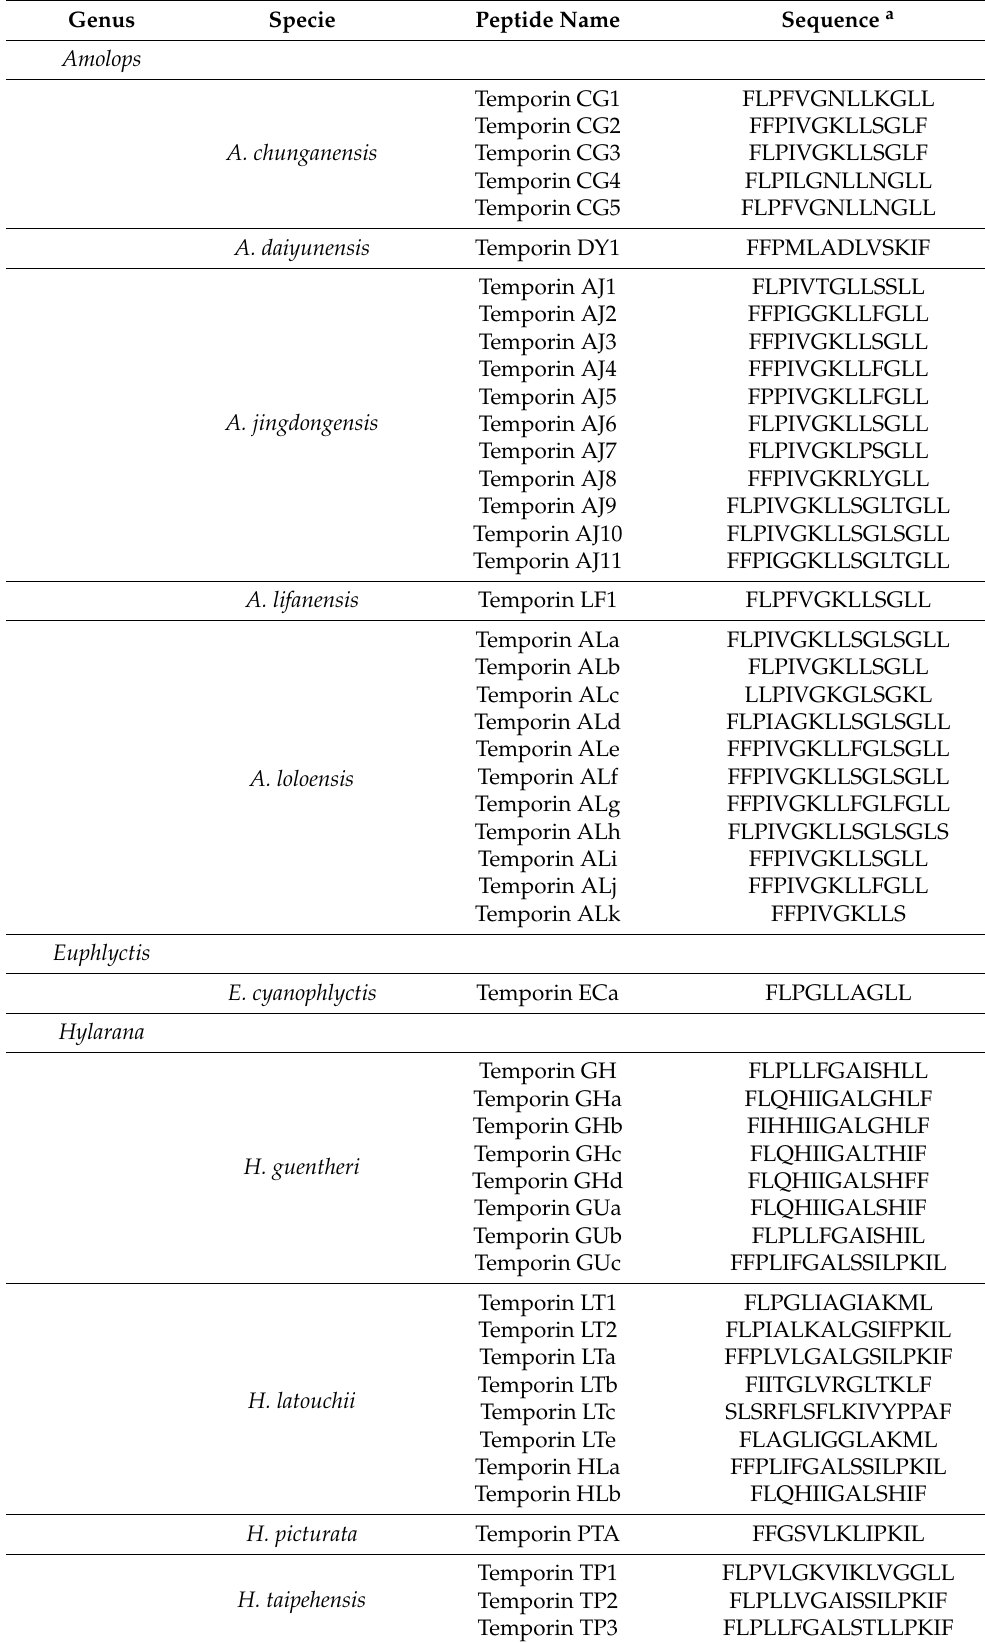
Table 1. Temporin sequences divided by frog genera as reported in the DBAASP database and recent reviews